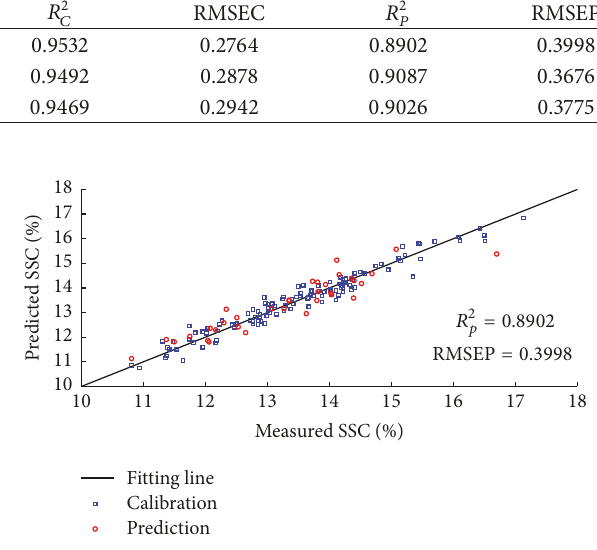
Figure 7: Prediction of soluble solids content (SSC) of apple in PLS regression with the best preprocessing